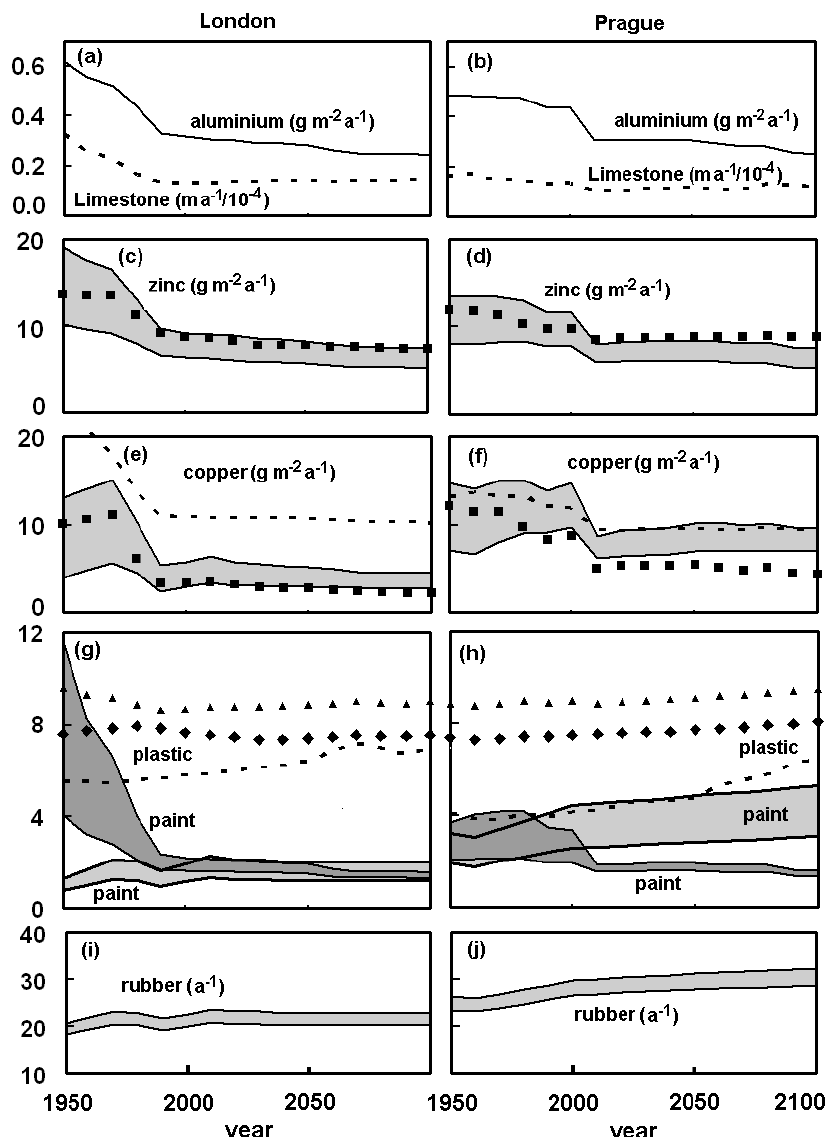
FIGURE 2. (a,b) Initial yearly rate of mass loss for exposed aluminum in London and Prague along with the recession to limestone. (c,d) Initial yearly rate of mass loss for zinc in London and Prague. The shaded area marks the lower bound (sheltered) and the upper bound (the exposed) metal from the ICP equation. The points mark the values from the MULTI-ASSESS equation. (e,f) Initial yearly rate of mass loss for copper in London and Prague. The shaded area marks the lower bound (sheltered) and the upper bound (the exposed) metal from the ICP equation. The points mark the values from the MULTI-ASSESS equation and the dotted line is from the NMEP function. (g,h) Rate of deterioration of plastic (units in text) in London and Prague in terms of changes in IR absorption in polyethylene (dotted line), damage depth in polyurethane (diamonds), and color change in polyester (triangles). Damage to paints is shown as ICP estimates for damage to steel panels with alkyd and coil coated galvanized steel with alkyd melamine, in ASTM rankings, as the upper and lower bounds of the dark shaded area and second, in light shading, Whitehouse’s[31] estimates of the % increase in erosion rate of acrylic coil coating (upper bound) and oil-based house paint (lower bound). (i,j) Rate of damage to rubber in London and Prague[14,15], where the lower bound is the middle of the rubber and the upper bound the